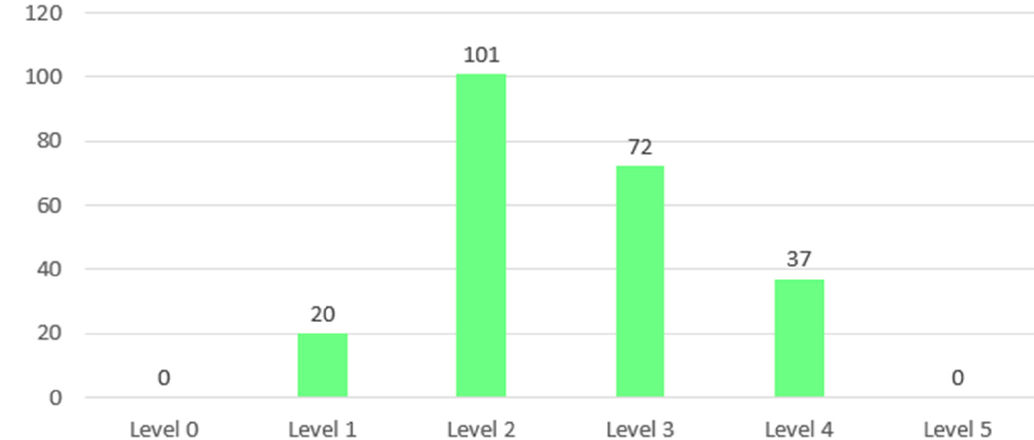
Figure 14. Number of values’ occurrences—electrical engineering.